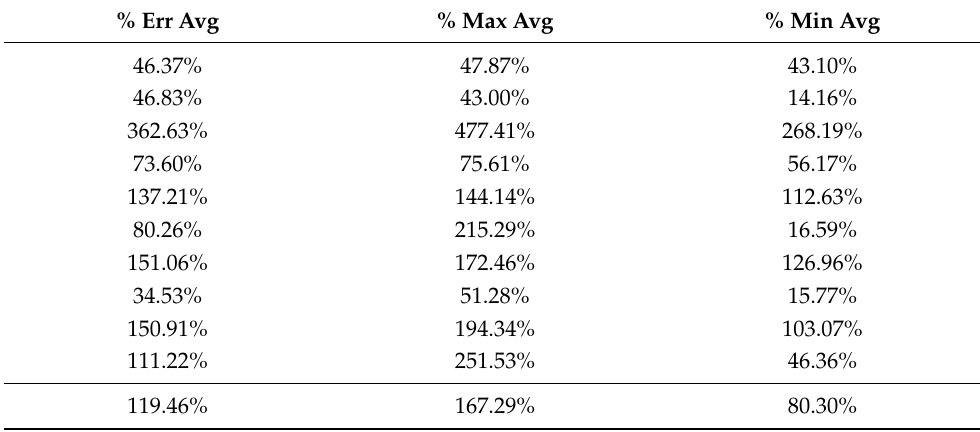
Table A73. Set 1, trials 41–50 data (all 0.5 PR values).